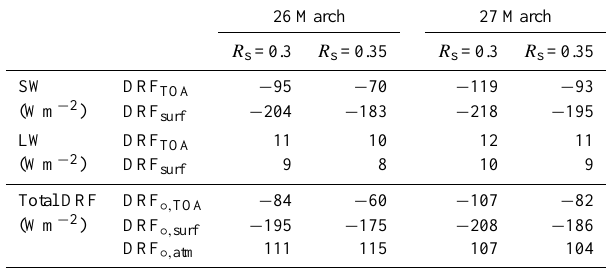
Table 4. Instantaneous shortwave and longwave DRF estimation for 26–27 March 2003 at two surface reflectances at 11:30LT ( + 3UTC).